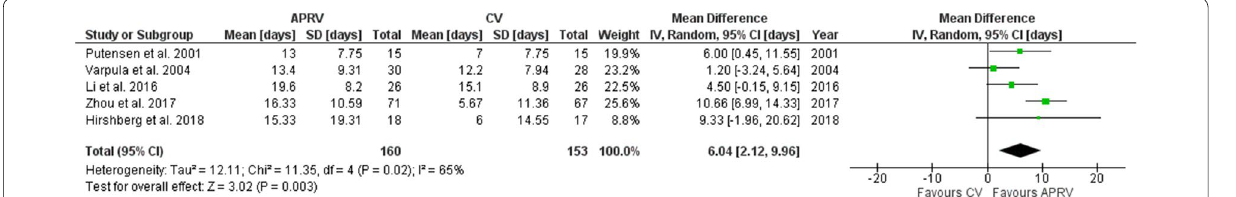
Fig. 2 Ventilator-free days at day 28. APRV airway pressure release ventilation, CV conventional